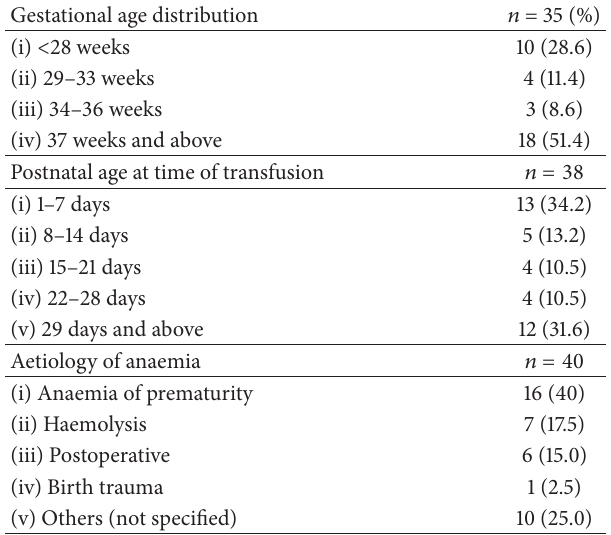
Table 1: Demographic characteristics of subjects and cause of anaemia.